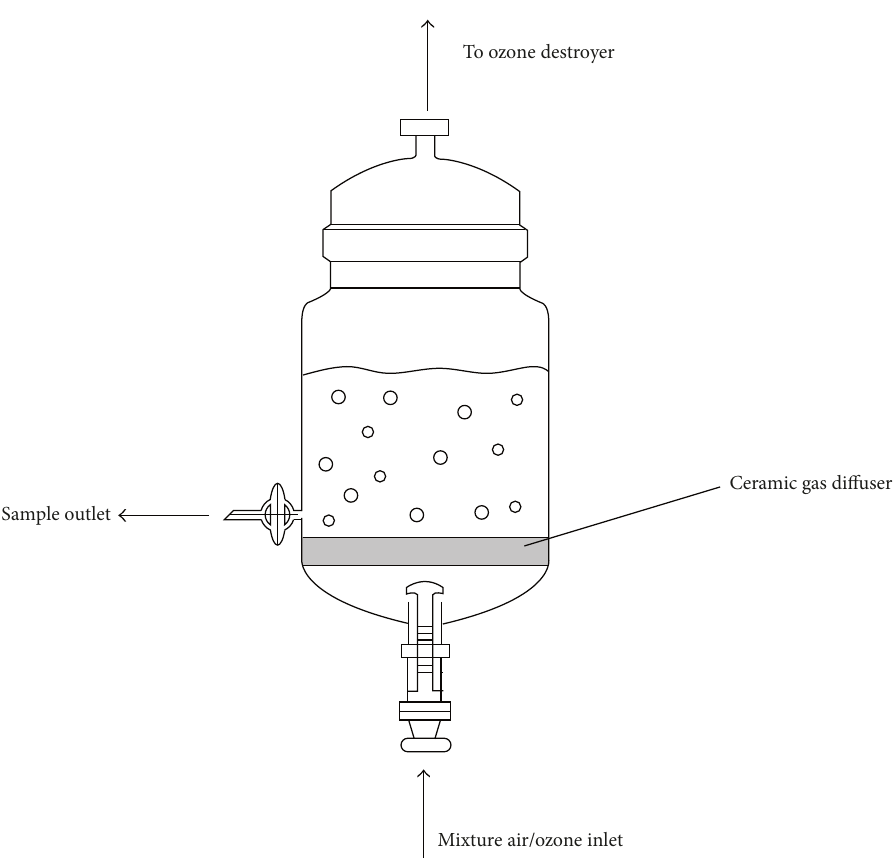
Figure 1: Schematics of the reactor used in the phenolphthalein degradation